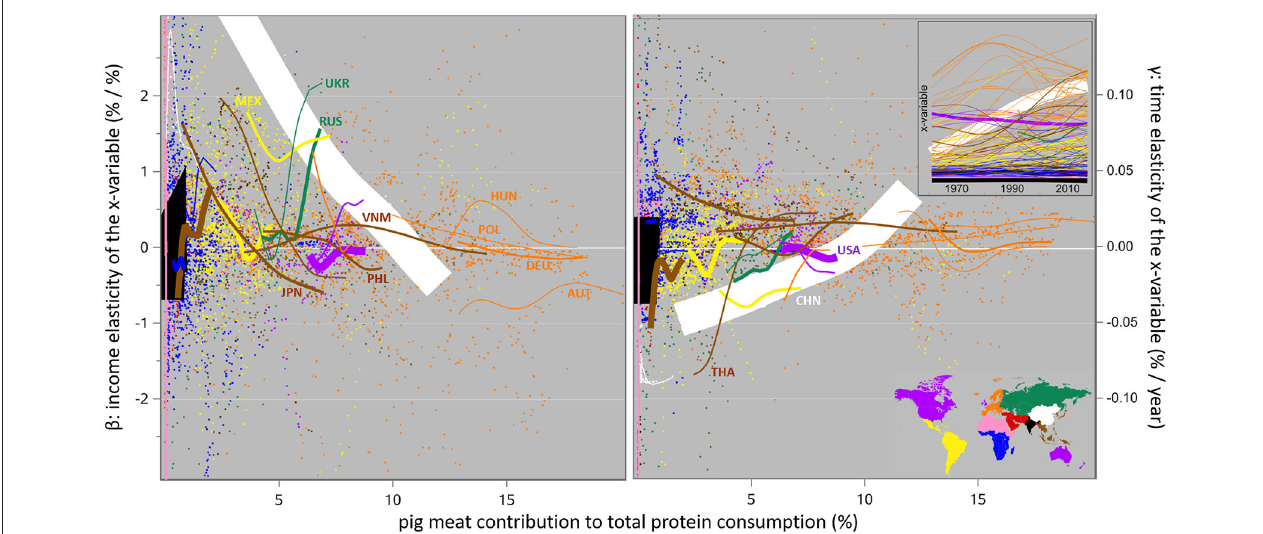
FIGURE 8 | Regression coefficients of the logarithm of the proportions of daily protein consumption that are based on pig meat, on the logarithm of annual income ( β : the income elasticity , adjusted for time-related non-income effects), and on time and its associated non-income effects ( γ : the time elasticity , adjusted for income effects), from 1961 to 2017. Note that the x-axes show the actual contribution % levels, not time; the time trends of the x-variable are shown in the inset. See Figure 6 for details on the